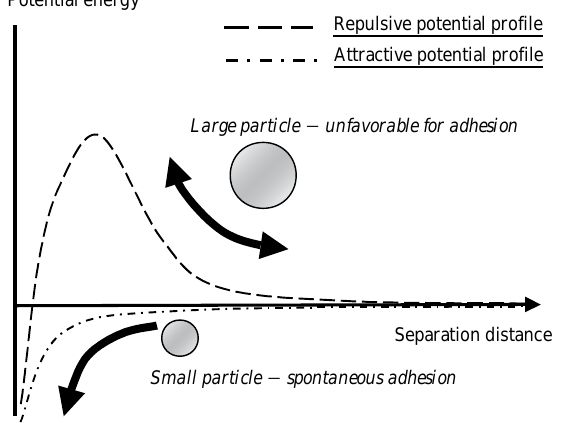
Illustration of potential curves and their influence on par- ticle adhesion to solid substratum.